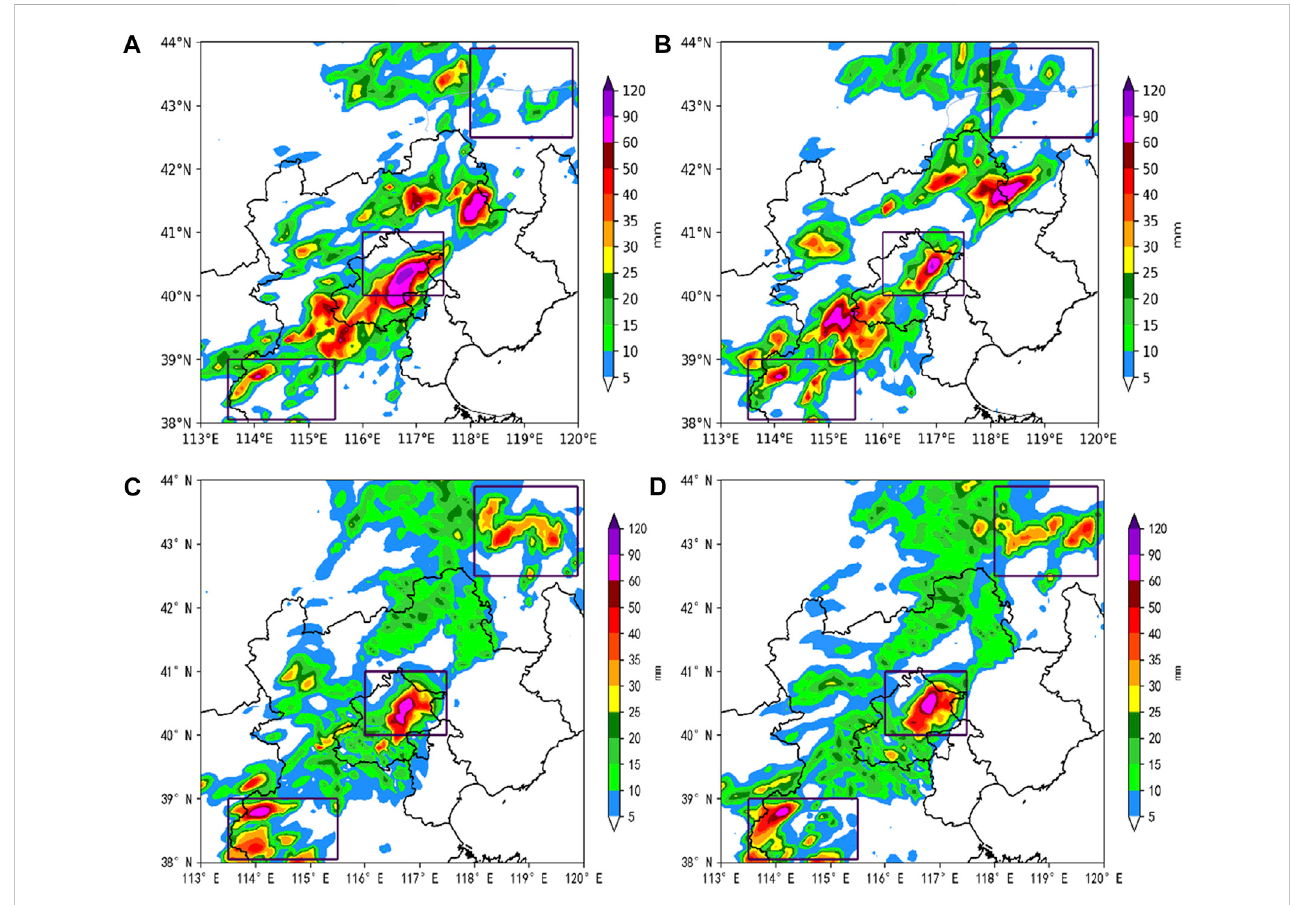
FIGURE 10 Simulated 6-h rainfall accumulation from (A) CTRL, (B) MWR_DA, (C) AGRI_DA, (D)